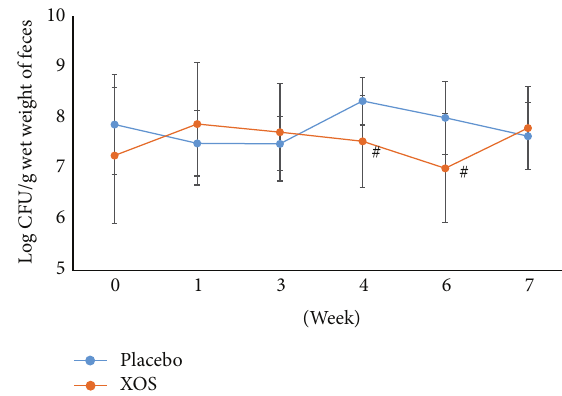
Figure 5: The changes in logarithm number (mean ± SD) of coliforms during the trial. Weeks 0-1: a run-in phase. Weeks 6-7: a 1-week washout phase. # Repeated measures ANOVA on different groups across time. 𝑝 < 0.05 .